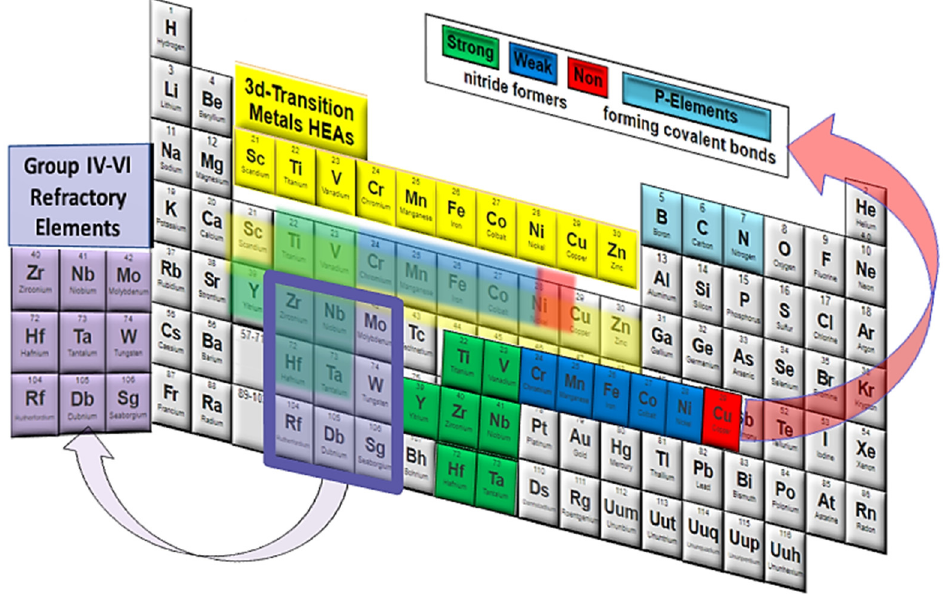
Figure 2. Periodic table of elements with highlighted elements that are most frequently used in the design of 3d-transition metal HEAs, refractory high-entropy alloys (RHEAs) and high-entropy ceramics (HECe). Reprinted with permission from [17] Copyright 2017 Elsevier.